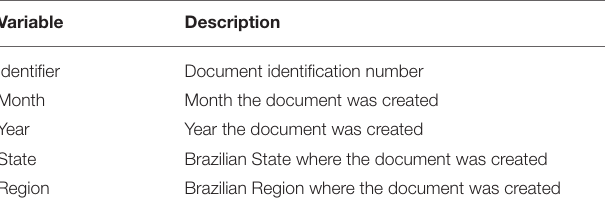
TABLE 1 | Document Indexing